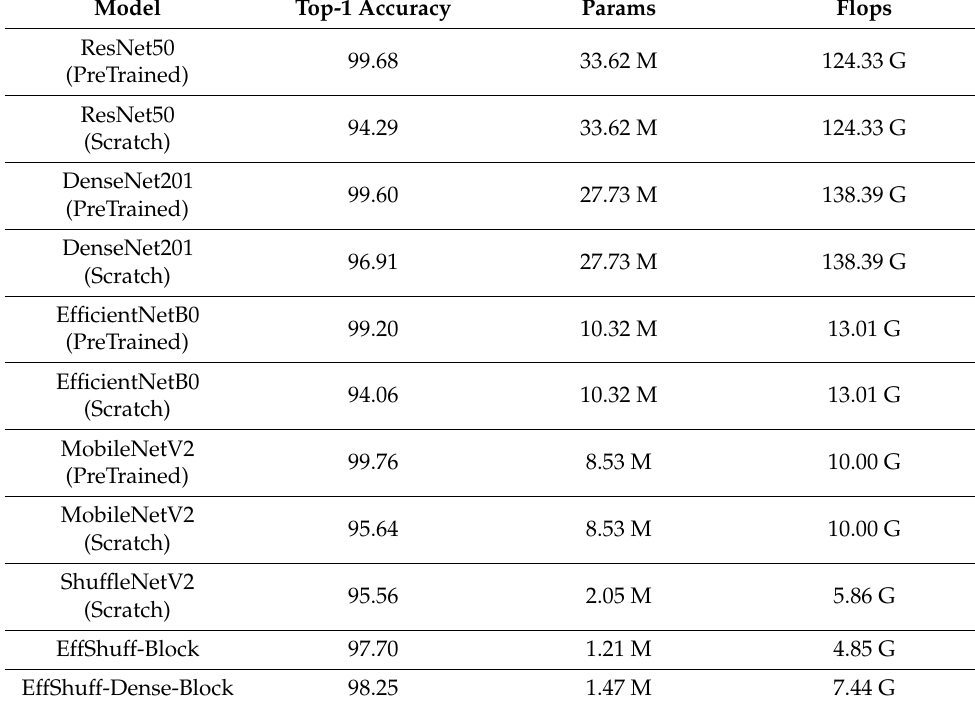
Table 5. Experimental results of butterfly and moth